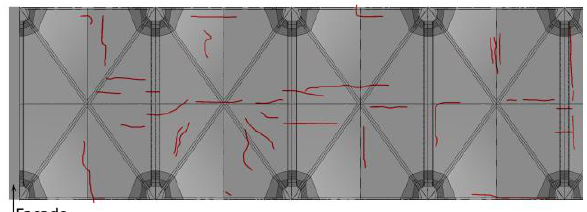
Figure 9. Documentation of the crack pattern in the nave of the church of St. Bassiano within BIM